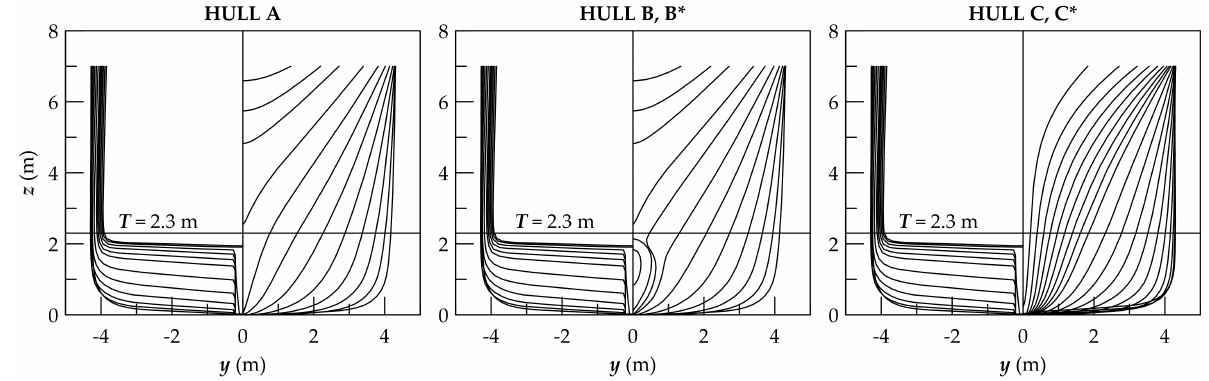
Figure 8. Sections of the hull forms considered in the study with conventional (Hull A), bulbous (Hull B) and vertical bow (Hull C),